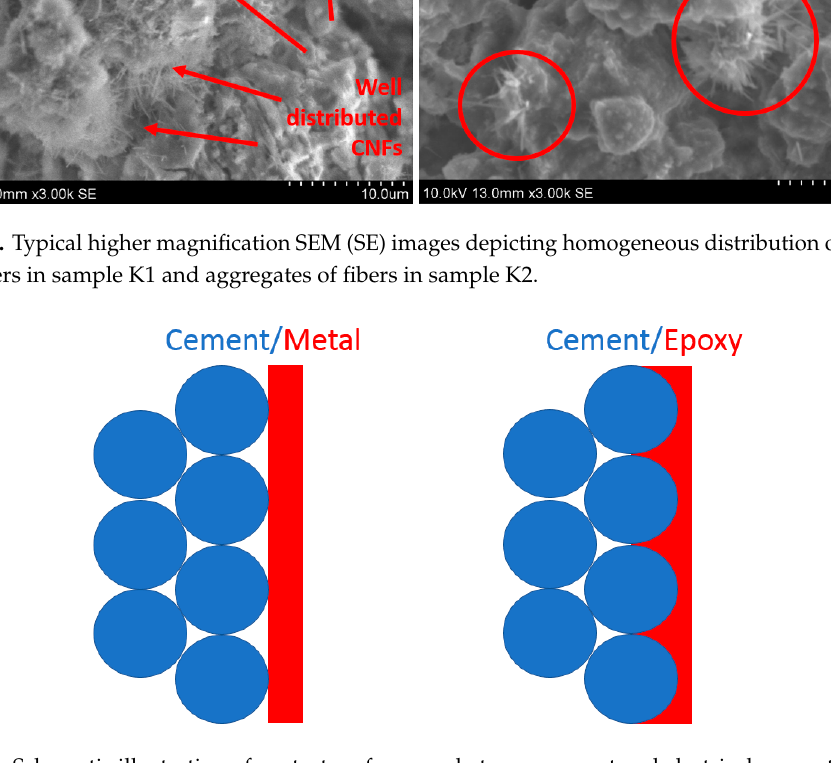
Figure 7. Schematic illustration of contact surface area between cement and electrical connector made of metal plate ( left ) and conductive epoxy resin ( right ).